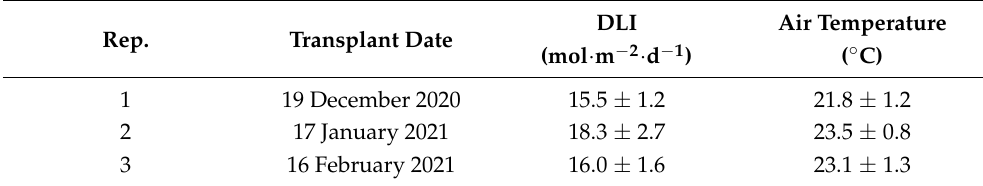
Table 2. The date of lettuce ‘Rex’ ( Lactuca sativa L.) transplant, daily light integral (DLI) ( ± SD ), and average daily air temperature ( ± SD ) during the finishing growth stage (21 d).